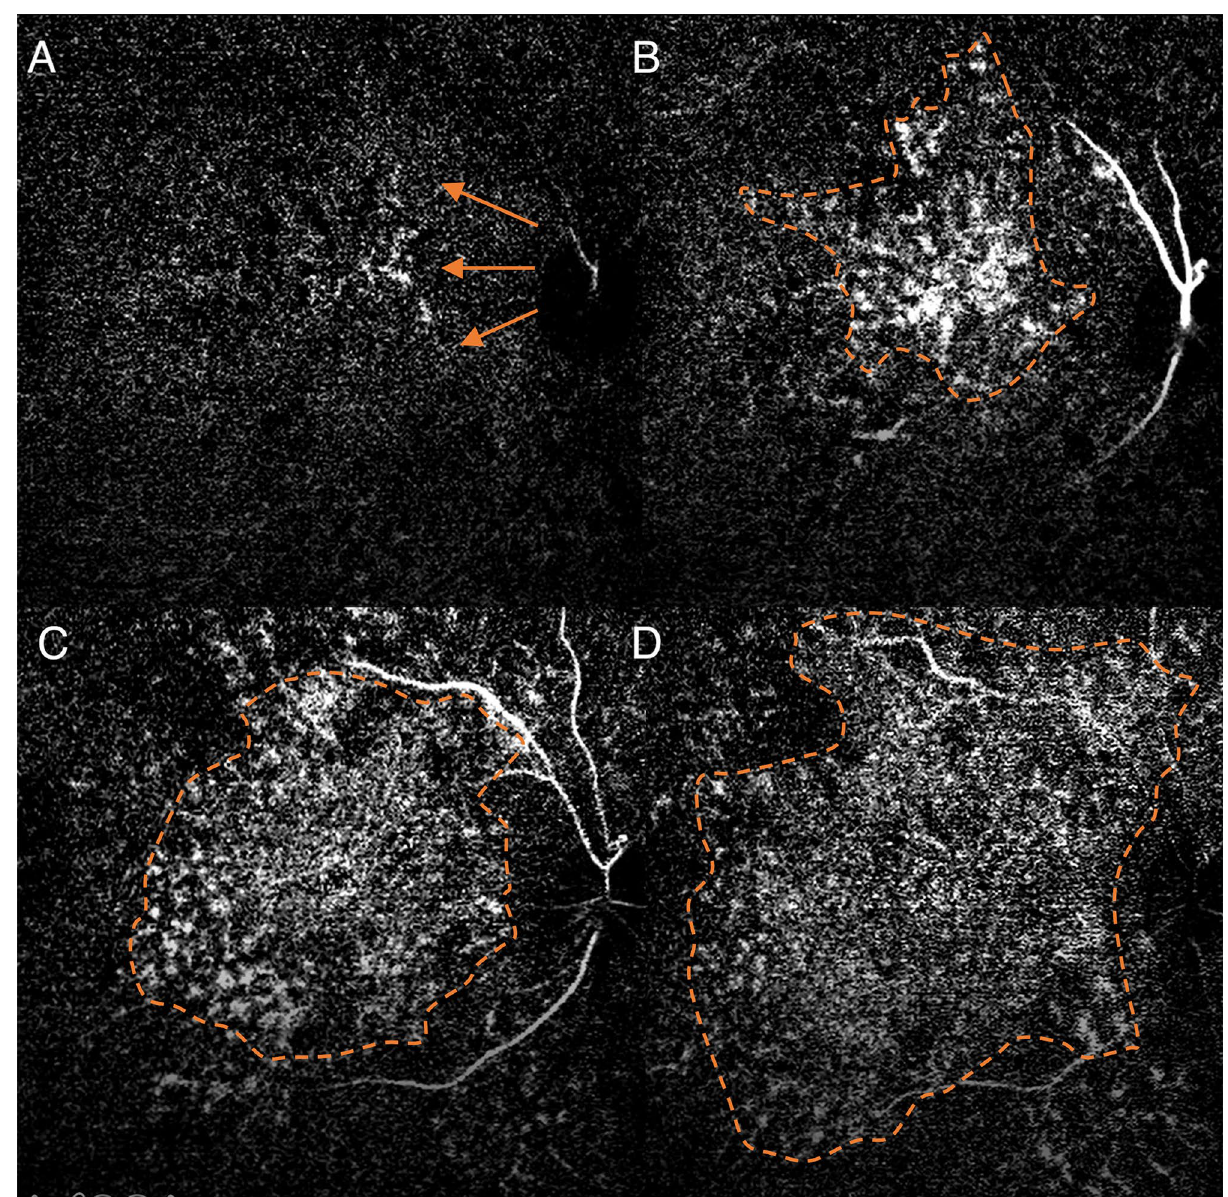
Figure 2. Digital subtraction indocyanine green angiography of the first monkey. ( A ) Dye first entered the peripapillary area of choriocapillaris in regions around the optic disc and posterior pole. (orange arrows). ( B ) A irregular segmented pattern can be seen as the choriocapillaris around the optic disc fills. ( C ) Dye filling progressed radially to the macular region. Many units of variable size and shapes were discernible, separated from each other by dark zone. ( D ) Dye filling in the posterior pole region appeared fairly pulsatile nature of the blood flow, and the radial progression repeated. Three cycles could be observed, recorded, analysed without any visual changes to the vascular structure or filling suggestive of steady flow. After dye first entered the macular area of choriocapillaris in regions around the optic disc and posterior pole (Figs. 2A, 3A), an irregular segmented pattern can be seen as the choriocapillaris fills in discrete units starting in the peripap- illary area and progressed radially to the macular region (Figs. 2B, C, 3B, C). The units of variable sizes were discernible, separated from each other by dark zones that were 50–200 µm wide. In the following frame, dye filling in the posterior pole region appeared fairly uniform, and the peripapillary area appeared dark (Figs. 2D, 3D). The segmented arrangements during different phases of the dye wavefront can be clearly discerned in Fig. 4. Each segment (functional lobule) is seen as an area of fast flow (Fig. 4A) surrounded by a perimetre of slow flow (Fig. 4B) shown as an overlay of red(fast) and blue (slow) flow in Fig. 4C. The dye front appears first in the centre of a quantised area as bright (Fig. 4A). The following subtracted frame shows the centre becoming dark, which implies no change in fluorescence as compared with previous frames, while the zones between adjacent units appear faintly bright (Fig. 4B). This suggests a slow movement of the dye front from centre (red zones) to the perimeter of each unit (blue zones) (Fig. 4C).